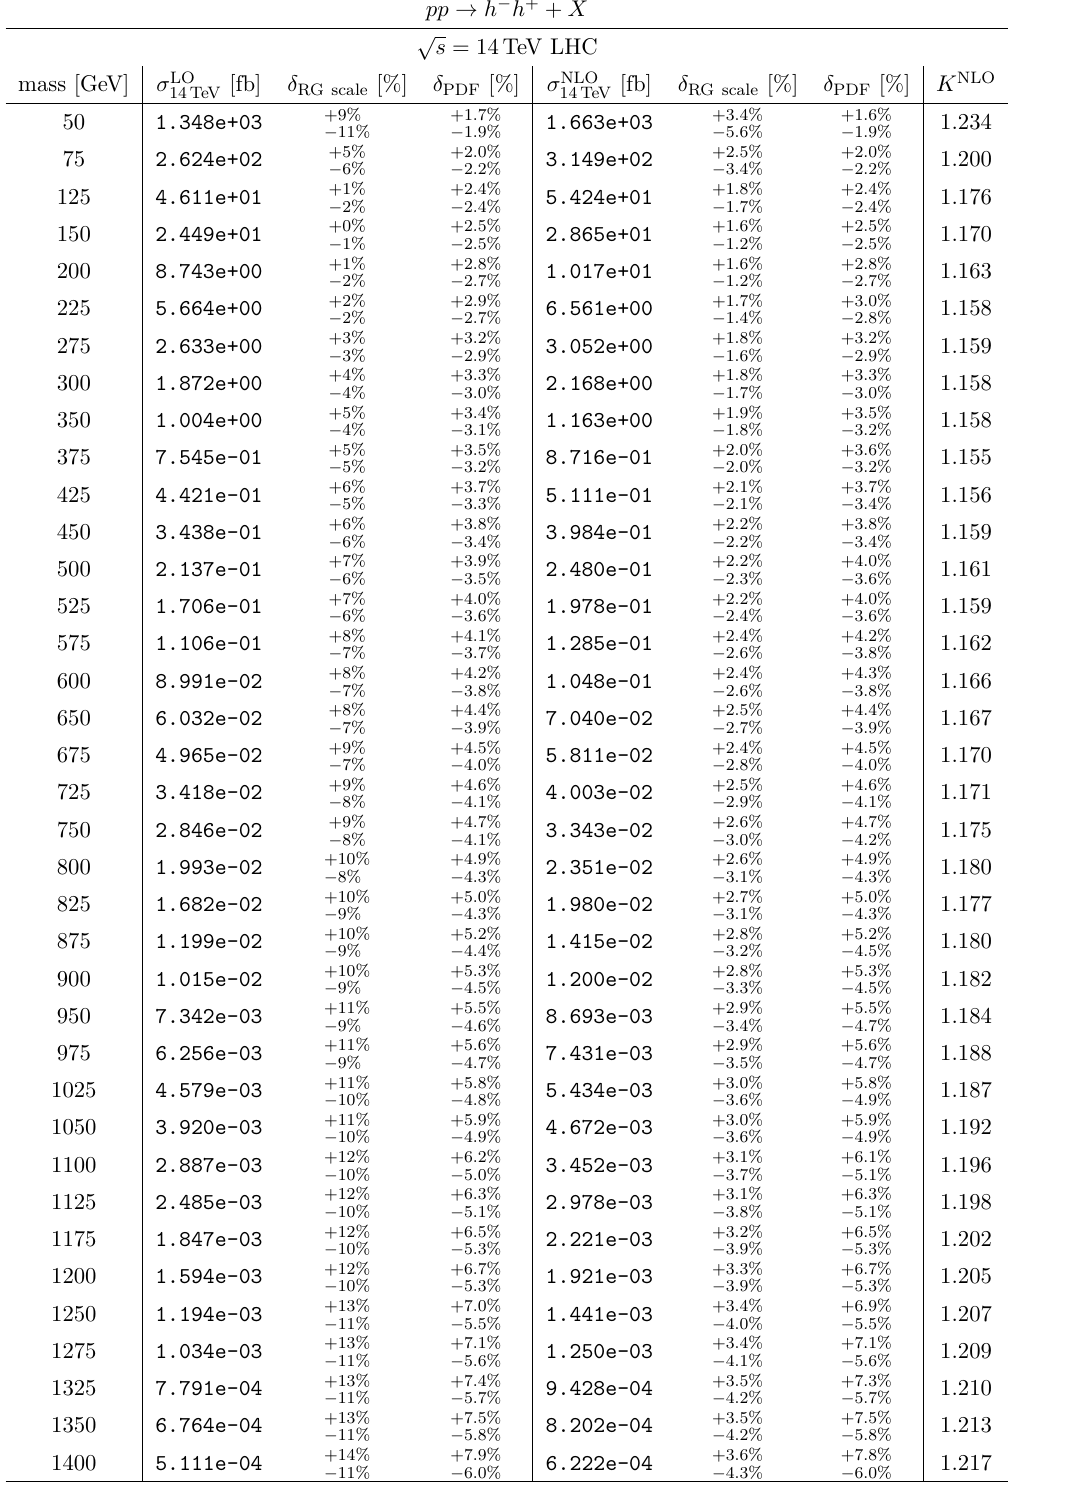
Table 9 . For representative masses m h [GeV] (first column), the predicted cross sections [fb] for √ s = 14 TeV at LO (second column) and NLO (third column) in QCD for inclusive pp → h − h + + X via the Drell-Yan process (DY). Also shown are scale uncertainties [%], PDF uncertainties [%], and the QCD K -factor. See section 3.2 for SM